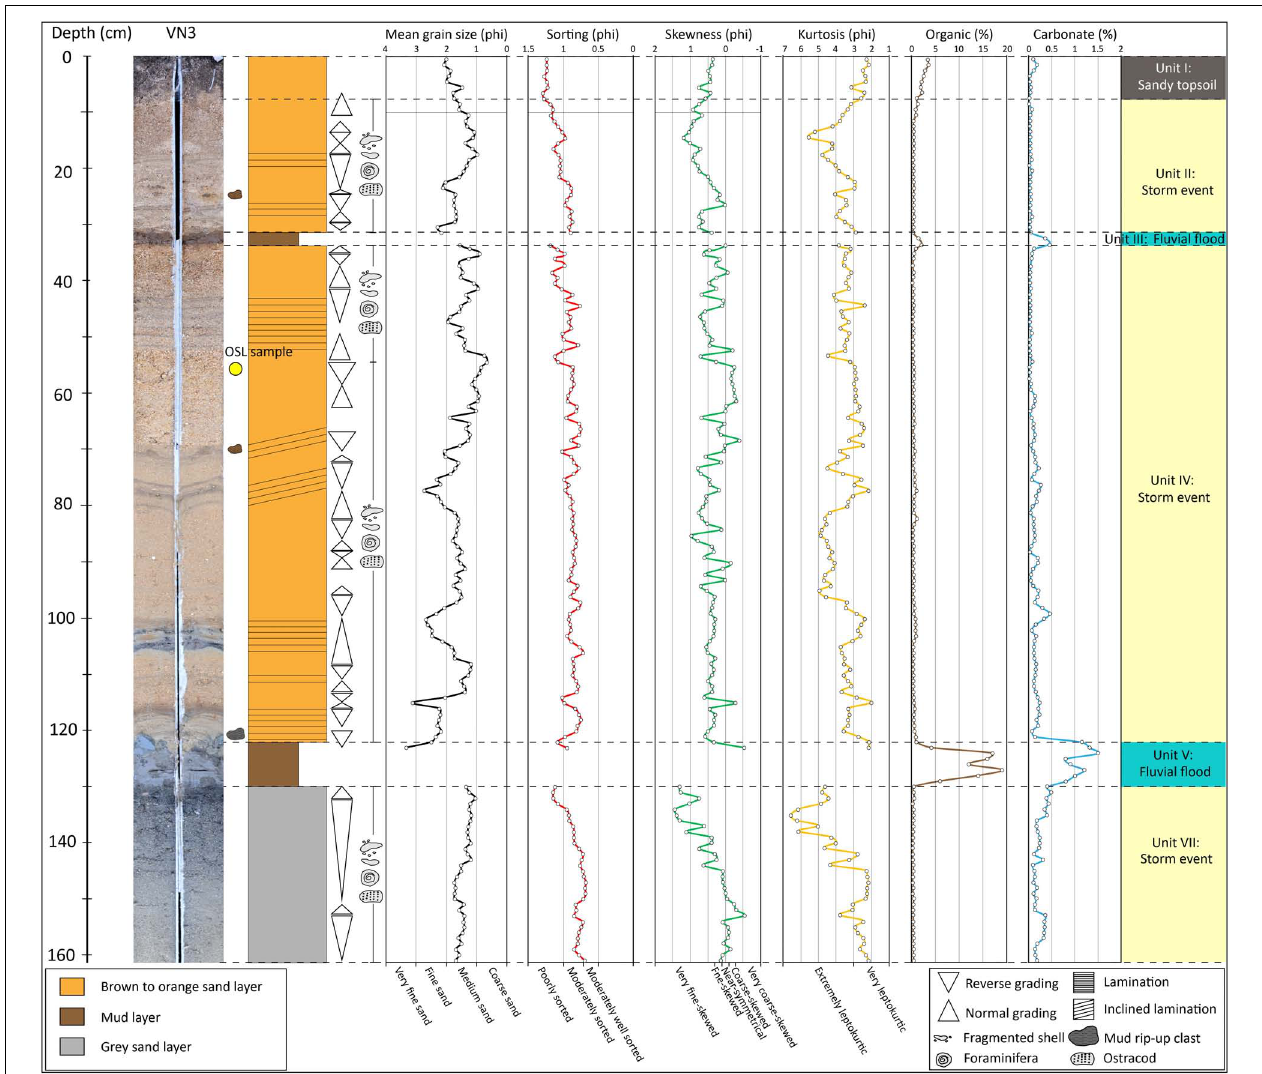
FIGURE 6 | Stratigraphy of core VN3 with vertically plotted grain size parameters (mean, sorting, skewness, and kurtosis) and LOI (organic and carbonate content) showing the unit of the storm and FF layers. Storm layers in Units II, IV, VI, and VII mostly exhibited the sets of normal and reverse grading with relatively low organic and carbonate contents, whereas the FF layer of Units III and V showed high organic and carbonate contents at 32–34-cm and 123–130-cm depths, respectively.